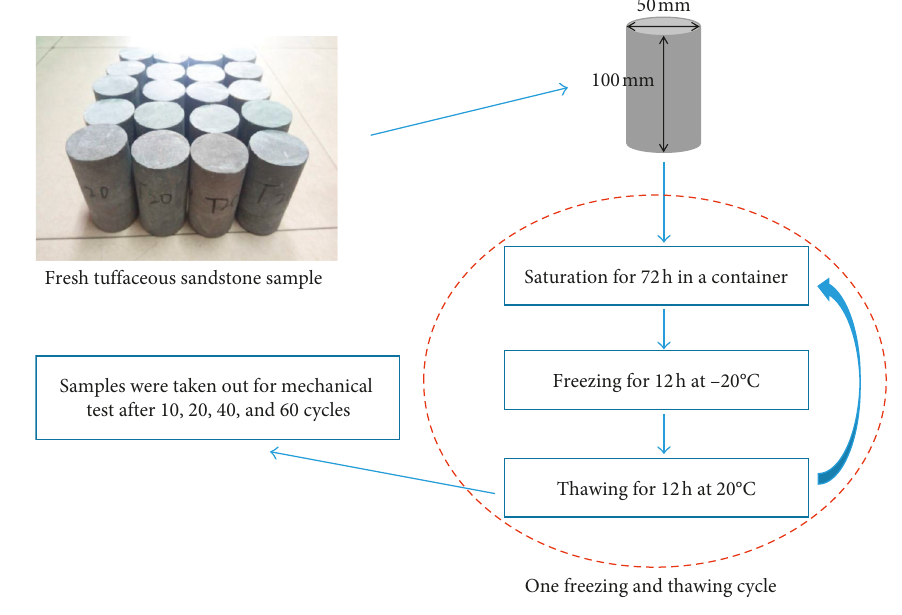
Figure 3: Experimental setup of freeze-thaw